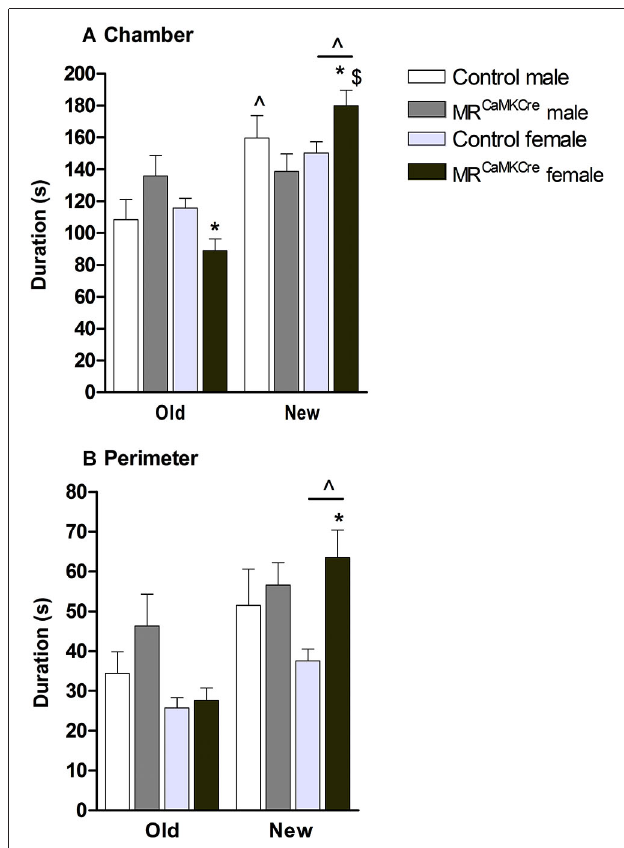
FIGURE 4 | Social discrimination in male and female MR CaMKCre and control mice . Time in seconds, spent in (A) the chamber and (B) the perimeter around the cylinder. White bars represent control males ( n = 9) and light grey bars represent the female control mice ( n = 15). Dark grey represent the male MR CaMKCre mice ( n = 8) and black bars the female MR CaMKCre mice. * p < 0.05 compared to controls same treatment; $ p < 0.05 compared to the males. ^ p < 0.05 compared to old stranger. All data are expressed as mean ± S.E.M.